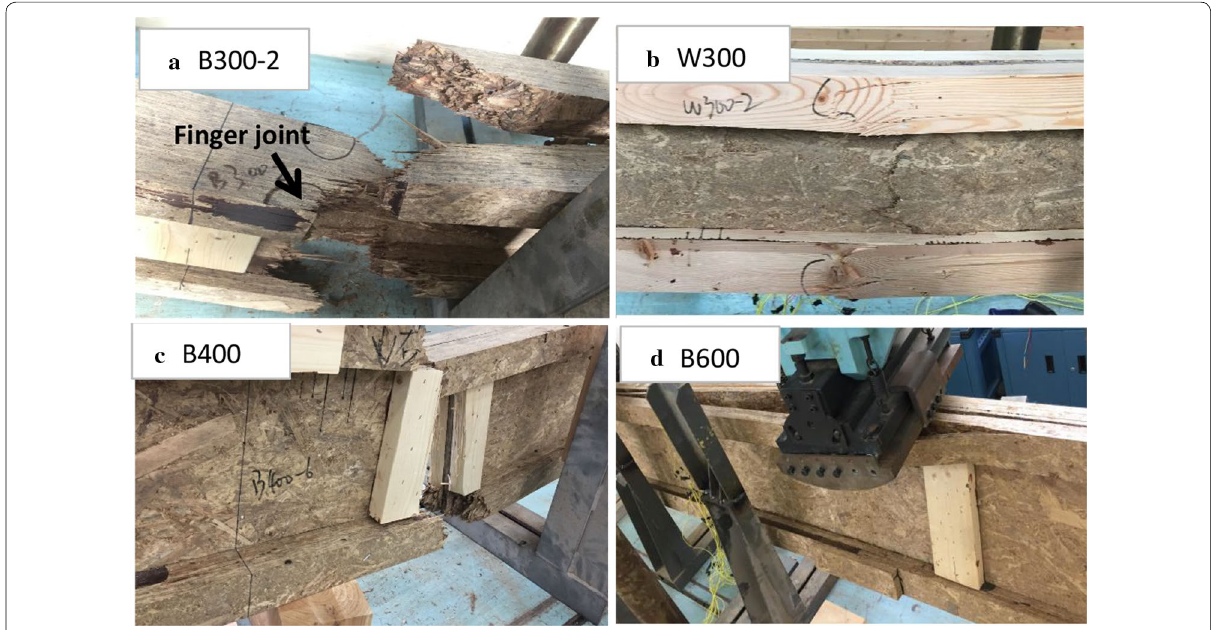
Fig. 4 I-beam failure pattern: a FTJ; b FT caused by knot; c SF in the nail-glued junction; d